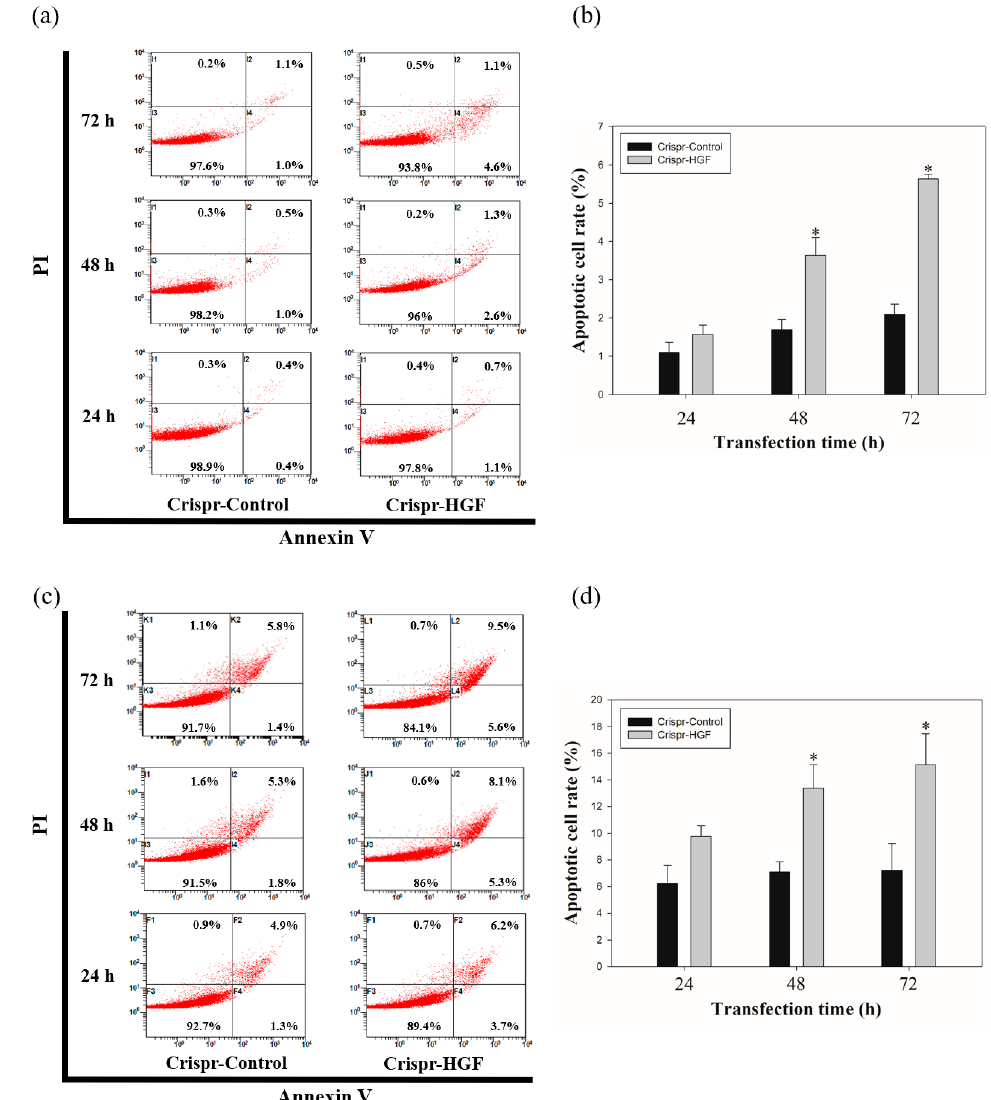
Figure 9. Apoptosis in Crispr ‐ HGF ‐ transfected ( a ) Huh7 and ( c ) Hep3B cells. Annexin V/PI staining assay determine if Crispr ‐ HGF induces apoptosis in both cells in a time ‐ dependent manner. Apoptotic cells rate was increased in Crispr ‐ HGF group compared to Crispr ‐ Control group in a time ‐ dependent manner. ( b , d ) The graph showed apoptotic cell rate for each group according to transfection time. Error bar represents the mean ±SEM. * p < 0.05. These assays were performed at least three times in